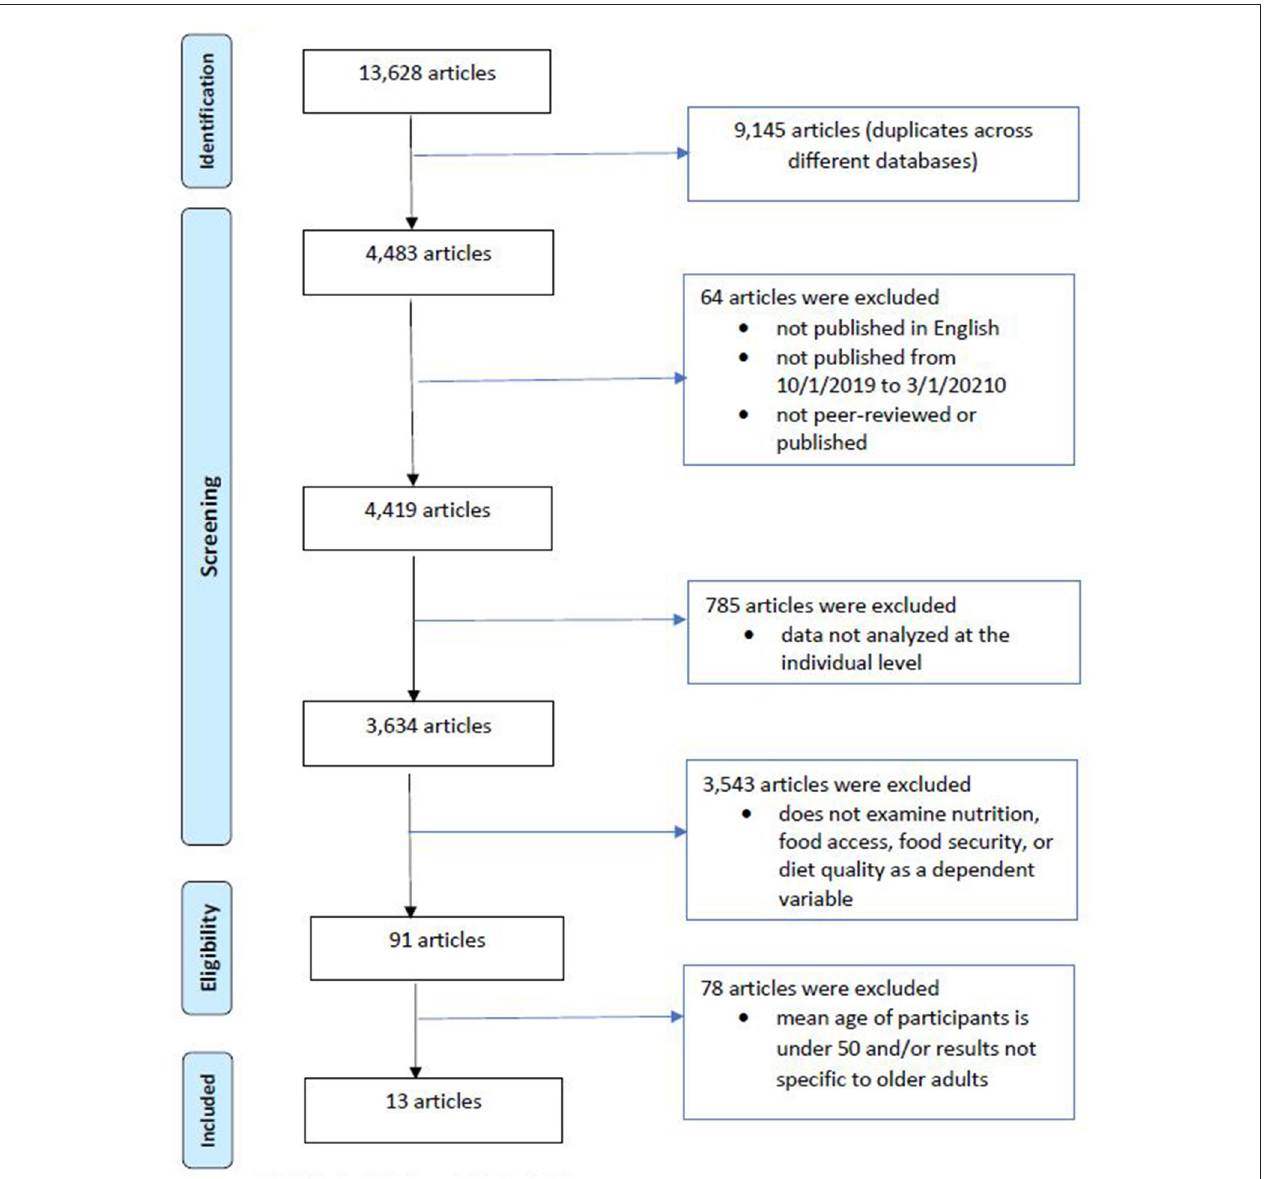
FIGURE 1 | Literature search strategy: sources and exclusion criteria (published October 1, 2019 to March 1, 2021). CINAHL, PubMed, and Web of Science. Key search terms for capturing food access during COVID-19 included food access (or food security, food insecurity, diet, nutrition), older adults (or older adult, elder, elderly), and COVID-19 (or coronavirus). Above figure adapted from Moher et al. (38).